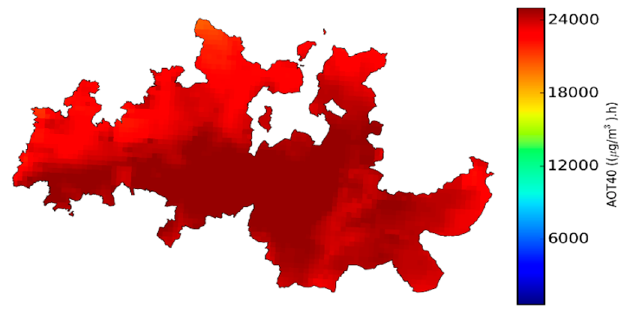
Figure 8. AOT40 levels ( μ g·m − 3 ·h) averaged for the 3 simulation years in the DDR (D04, 1 × 1 km 2 horizontal resolution).